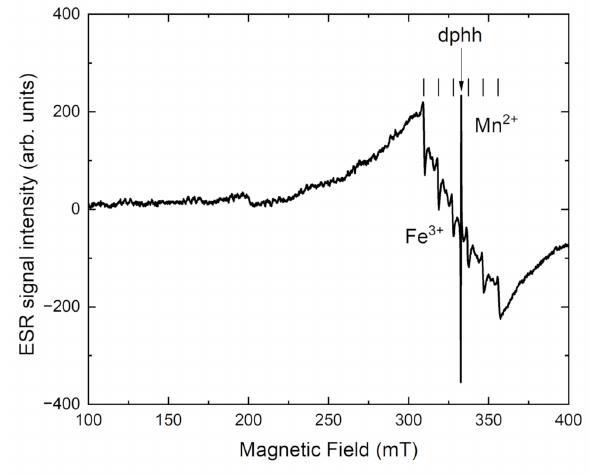
Figure 11. ESR spectrum of